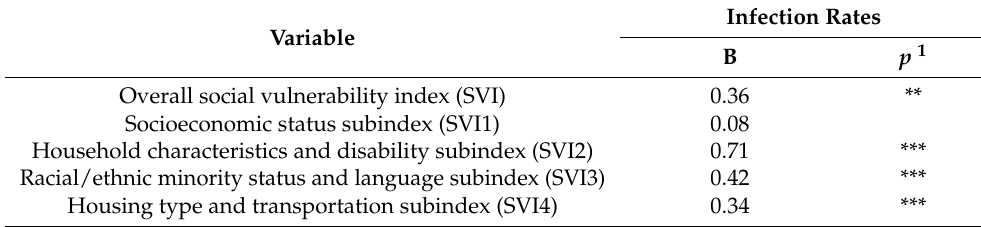
Table 1. SVI and COVID-19 infection rate regression results.